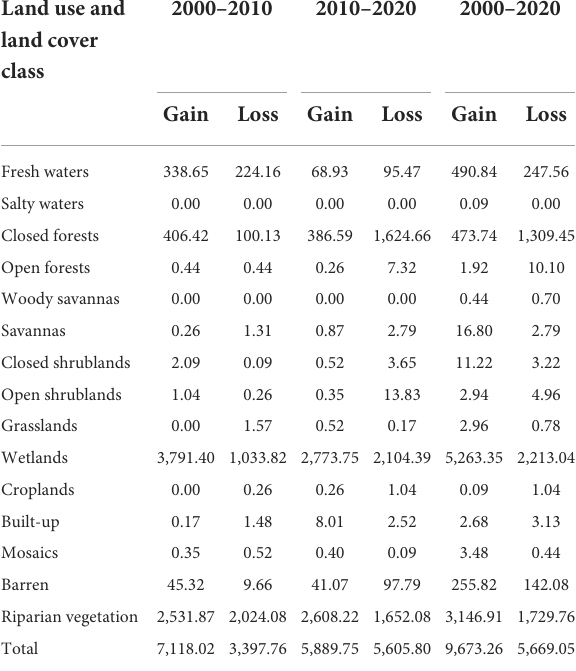
TABLE 4 Quantitative estimates of mangrove dynamics and changes magnitude in relation to major land use and land cover of The Gambia between 2000 and